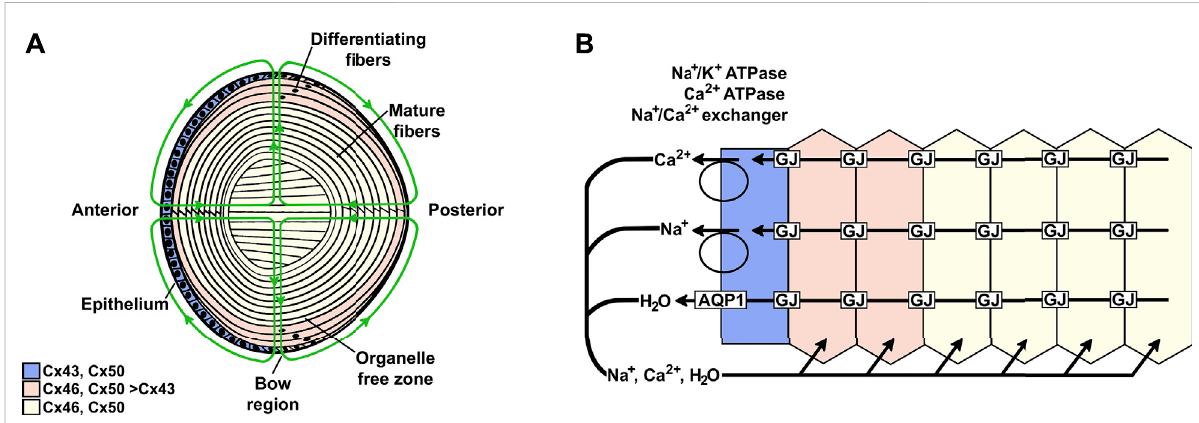
FIGURE 1 Model of the lens and the distribution of different connexins. (A) The lens contains two cell types: an anterior epithelial cell layer and elongated fi ber cells that constitute the bulk of the organ. At the lens equator (bow region), the cells start differentiating, a process that includes elongation of the cells and the loss of organelles to form fi ber cells that are added as sequential layers. Thus, the differentiating fi ber cells are more super fi cial, and the mature fi bers are located deeper within the lens. Three connexins (Cx43, Cx46, and Cx50) are differentially distributed in the regions of the lens. The green lines indicate the lens circulation of water and ions; arrowheads indicate the direction of fl ow. The movement of fl uid is coupled to the circulation of ions. (B) Diagram illustrating the movement of Na + , Ca 2+ , and water in a cellular column from the lens. Ions enter into the lens through the spaces between cells at the anterior and posterior poles and move towards the lens center. As they move to the center, ions are driven into fi ber cells by their electrochemical gradients; then, they fl ow from cell-to-cell from the lens center to the epithelial cells on the lens surface throughgapjunctionchannels andexitthelensatthebowregion.Theionsaretransportedoutofthelensbyepithelialpumps,andwater movesout through AQP1